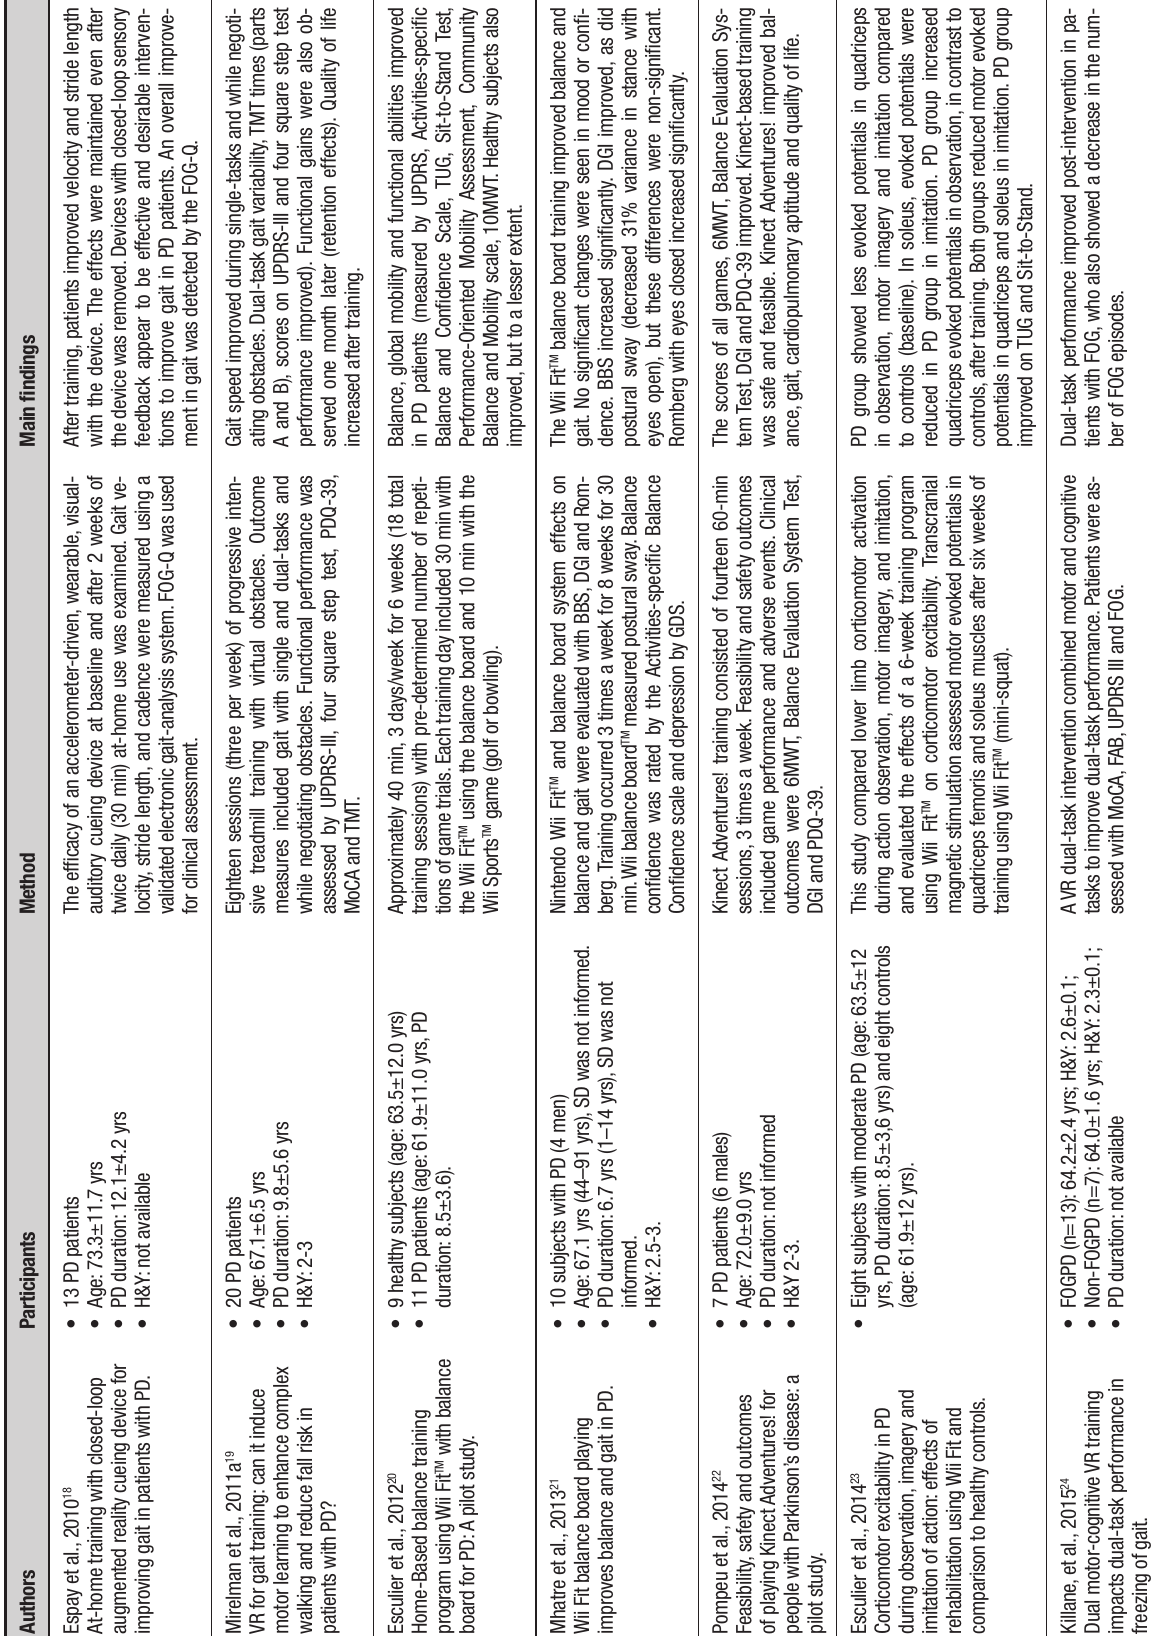
262 Visual reality and gait in Parkinson’s disease Freitag et